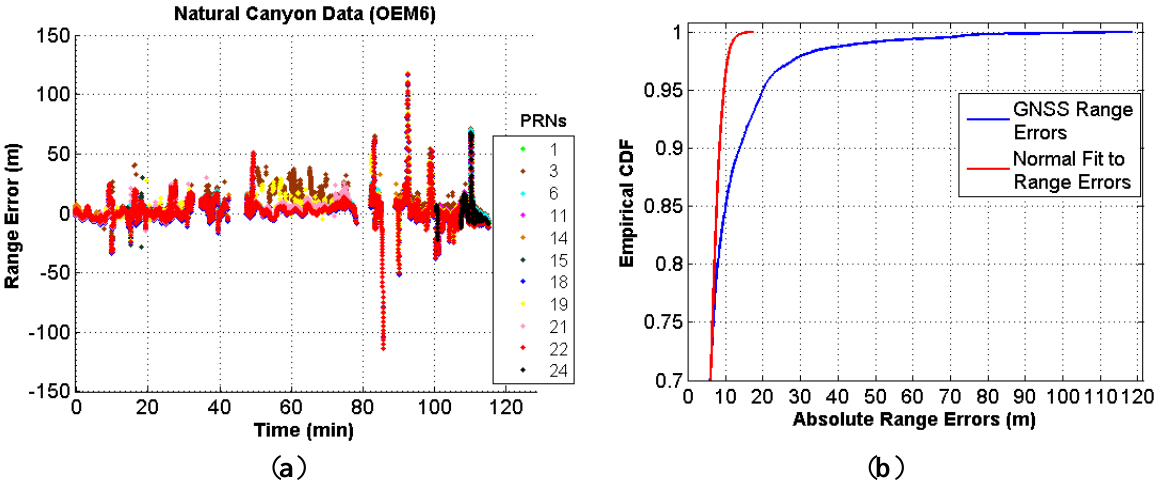
Figure 12. ( a ) Range errors in natural canyon (OEM6) ( b ) Range error distribution in natural canyon